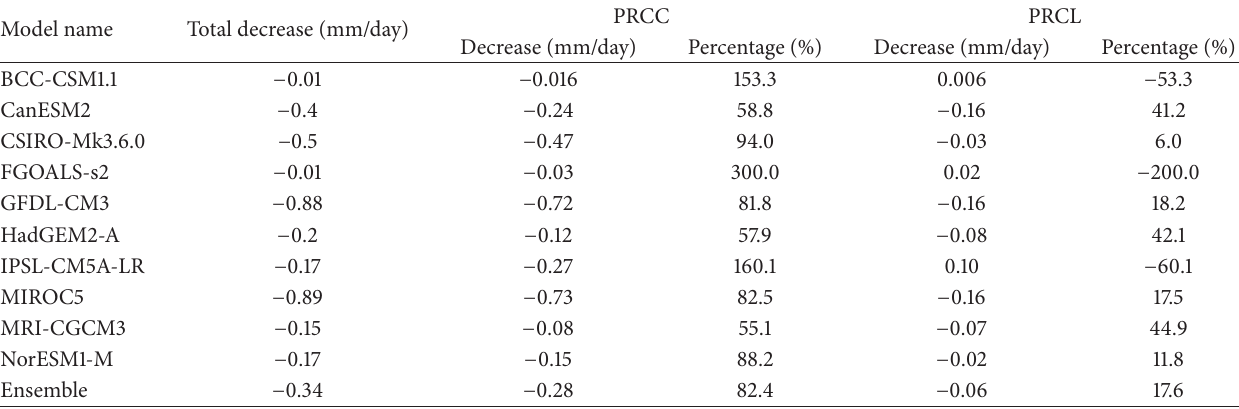
Table 3: Convective precipitation (PRCC) and large-scale precipitation (PRCL) difference between the aerosol run and CTL run and the ratio of the difference to the total precipitation decrease.